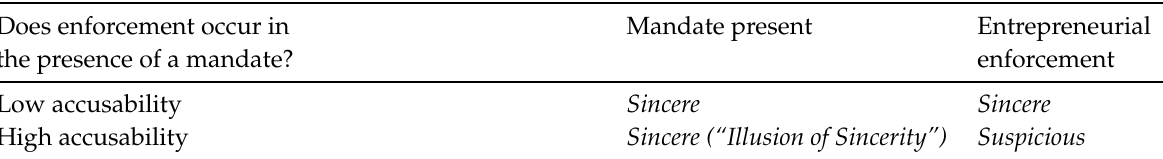
Table 1: Theoretical predictions of when norm enforcers seem sincere or suspicious. Does enforcement occur